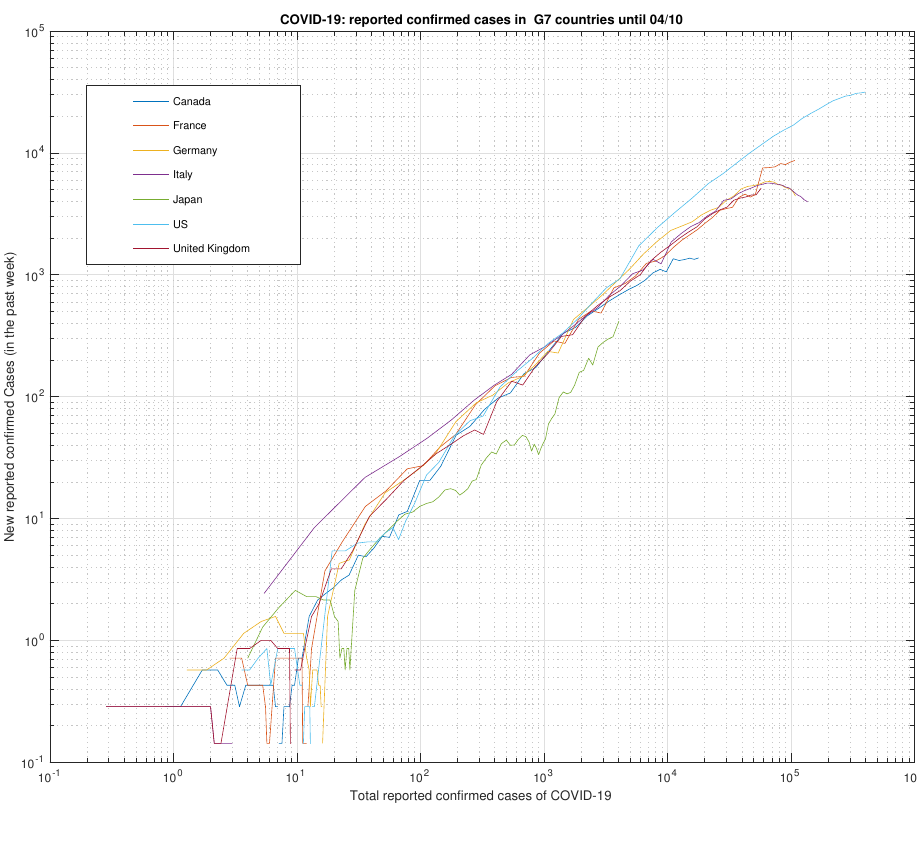
Figure 14. COVID-19 samples in G7 countries.